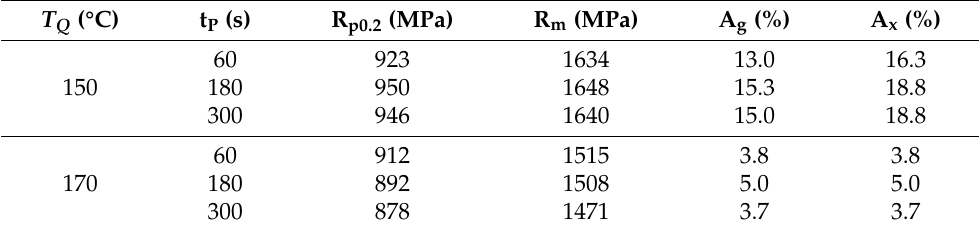
Table 2. Mechanical properties in dependence of tp for T Q = 150 °C and 170